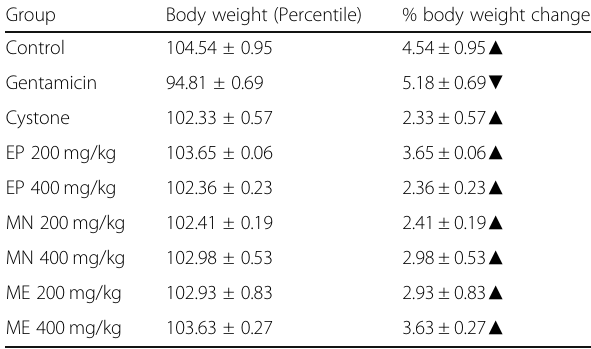
Table 1 Effects of three actinorhizal fruits on the body weight of the treated